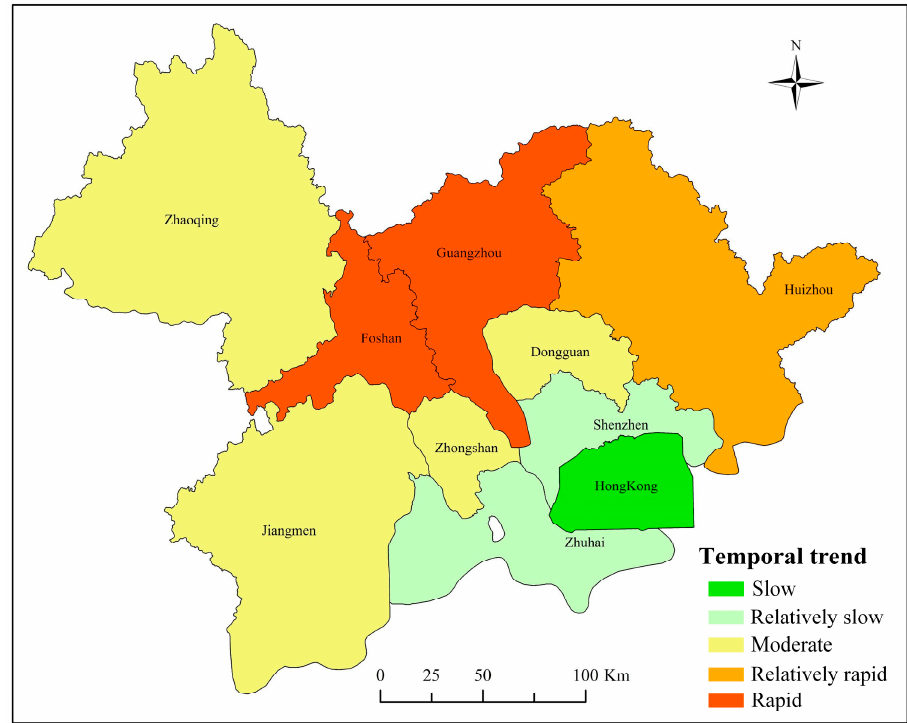
Figure 11. Variation types of ISA% from 2000 to 2019 in the study area.